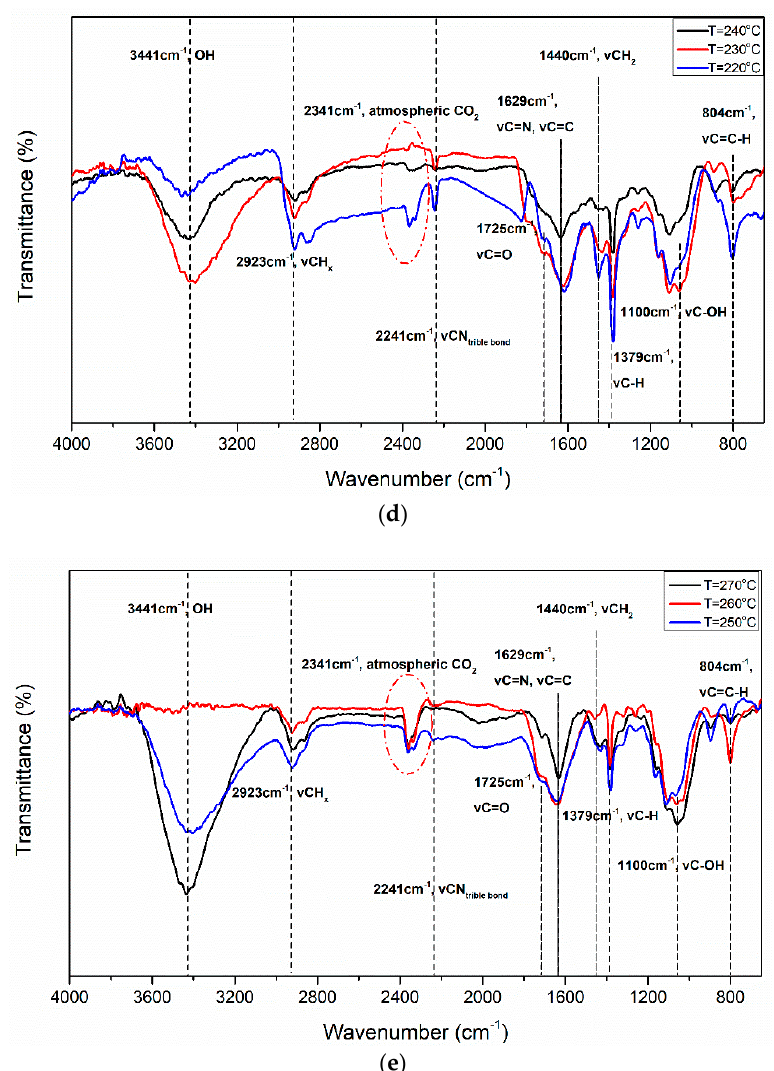
Figure 11. Fourier Transform Infrared Spectroscopy (FTIR) spectra of virgin and stabilized fibers in range of ( a ) untreated, ( b ) 160–180 °C, ( c ) 190–210 °C, ( d ) 220–240 °C, and ( e ) 250–270 °C. In each case, treatment duration was 4 h.